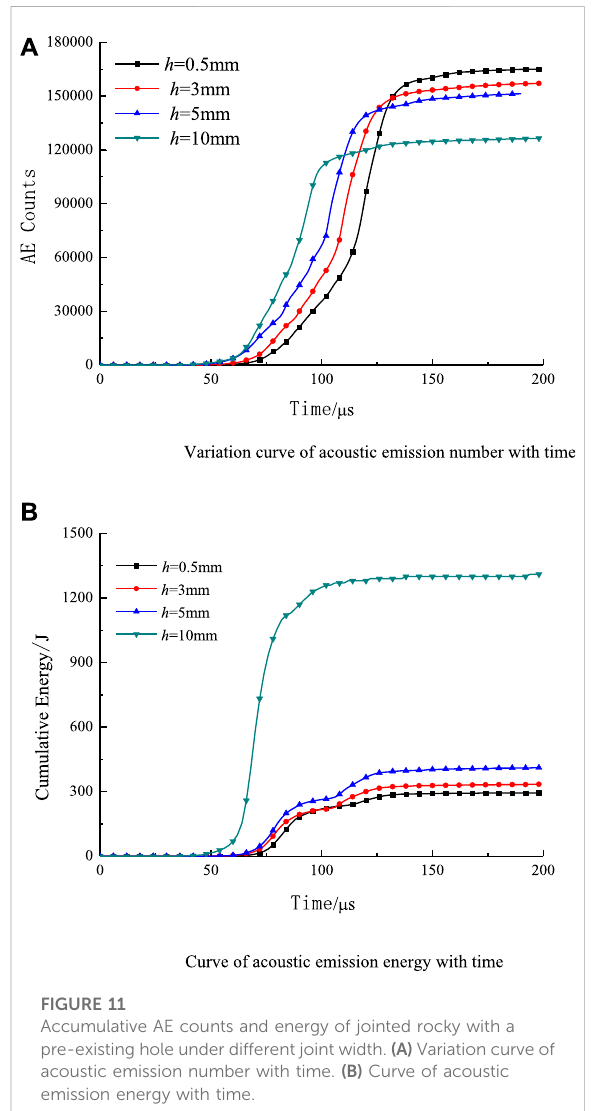
FIGURE 11 Accumulative AE counts and energy of jointed rocky with a pre-existing hole under different joint width. (A) Variation curve of acoustic emission number with time. (B) Curve of acoustic emission energy with time.